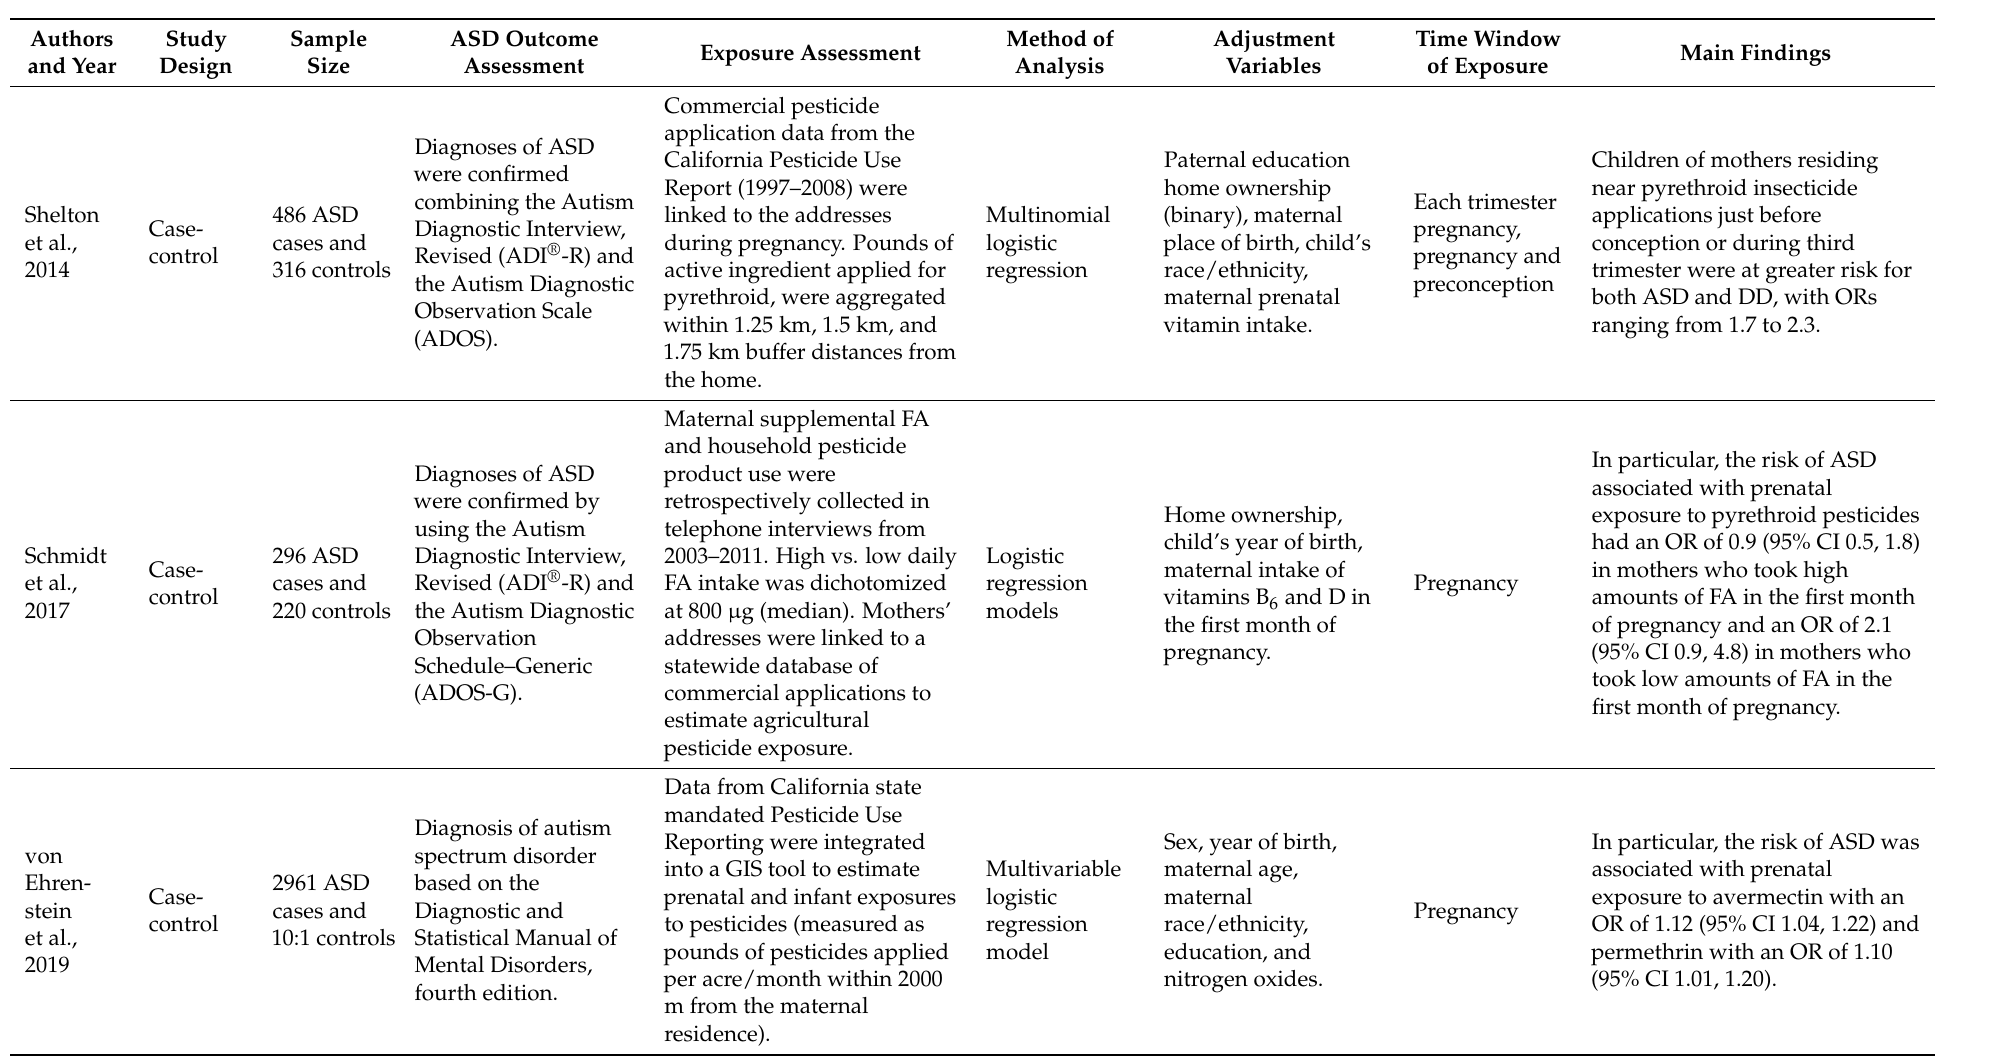
Table 3. Associations between pyrethroids and